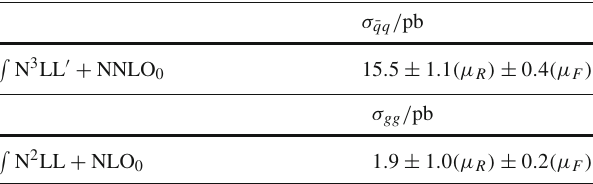
Table 3 Cross-sections at 8 TeV for q ¯ q and gg hard-function initiated γ (cid:9) and hybrid-cone isolation with inner cone processes with μ R = (cid:8) q T angle R 0 = 0 . 1